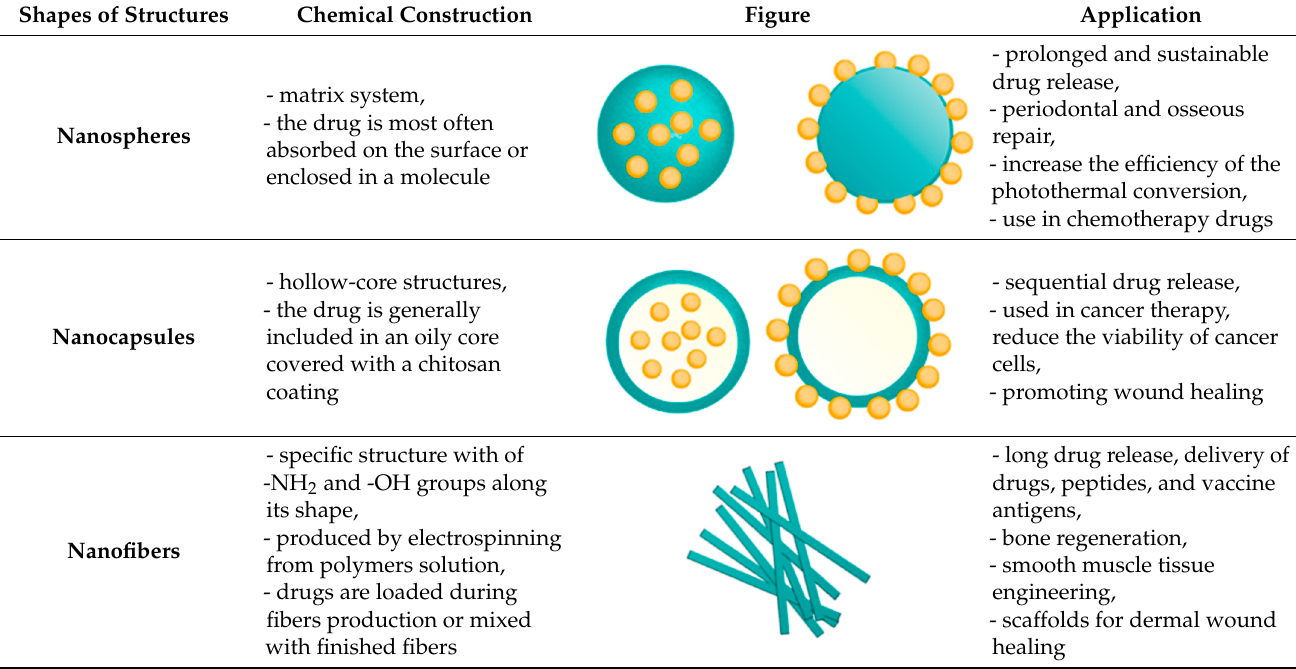
Table 1. Characteristics of the most commonly used shapes of chitosan nanoparticles (ChNPs).